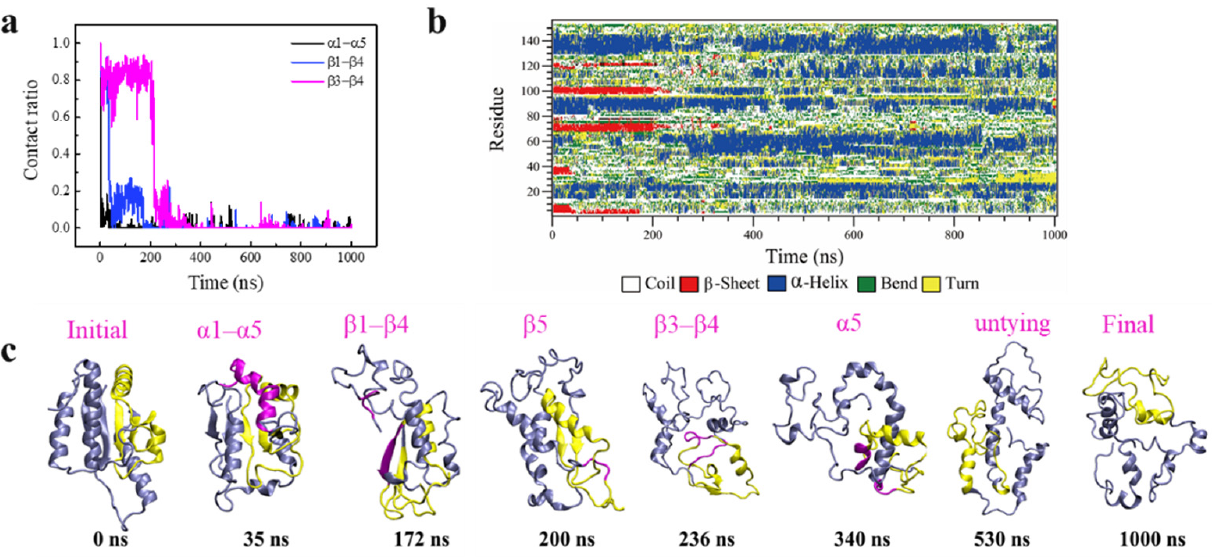
Figure 3. Simulation run 5 of the thermal protein unfolding, during which the knot was untied. ( a ) Time evolutions of the ratio of native contacts between selected domains of α 1 and α 5, β 1 and β 4, β 3 and β 4. ( b ) Time evolutions of the YbeA’s secondary structure change. ( c ) Time sequence of typical snapshots depicting the stepwise change of the protein structure under enhanced thermal fluctuations. The knotted region is colored in yellow. The major secondary structural change at each step is colored in purple.